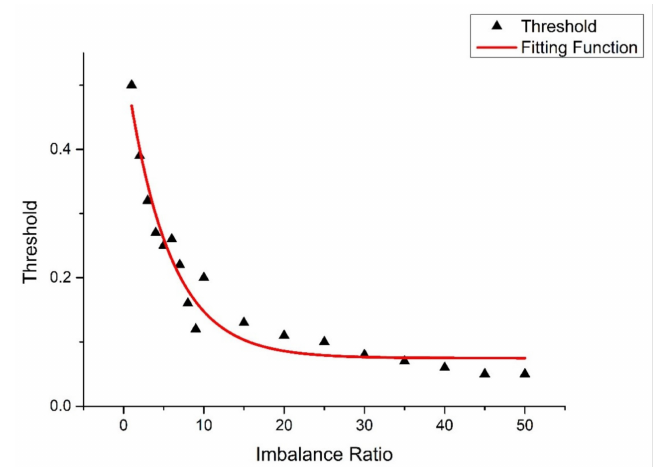
Figure 3. The fitting function between the imbalance ratio and the